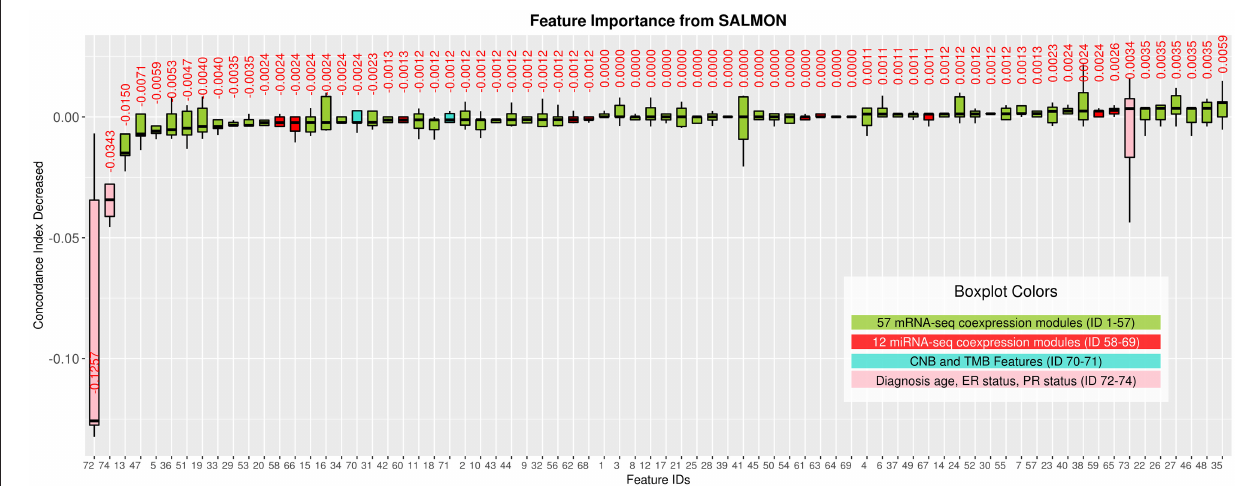
FIGURE 3 | Features importance evaluated by the decrease of concordance index, sorted based on median values. Boxplots in Green: 57 mRNA co-expression module features (ID from 1 to 57); boxplots in red: 12 miRNA co-expression module features (ID from 58 to 69); boxplots in turquoise: copy number burden (CNB) and tumor mutation burden (TMB) features (ID from 70 to 71); boxplots in pink: demographical and clinical features (ID from 72 to 74).